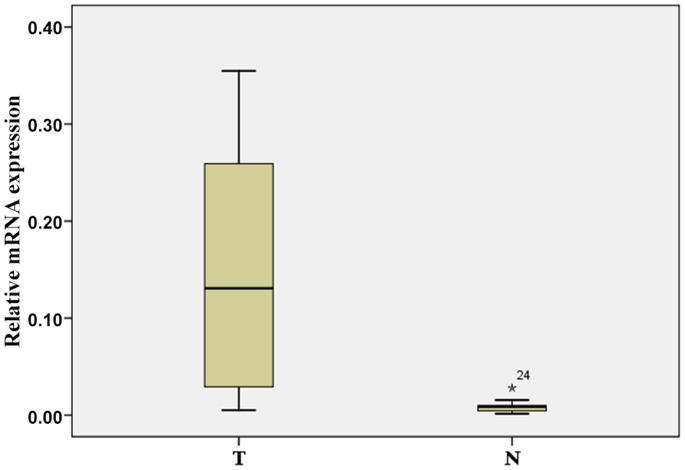
Real-time quantitative RT-PCR analysis of PNCK expression.The relative expression of PNCK mRNA in ccRCC tumor tissue samples was higher than that in the paired adjacent normal (N) tissue samples (n = 24, P<0.001). The bottom and the top of the box represent the 25th and the 75th percentile, respectively, and the band near the middle of the box is the 50th percentile (the median). The ends of the whiskers represent the 2.5th percentile and the 97.5th percentile.